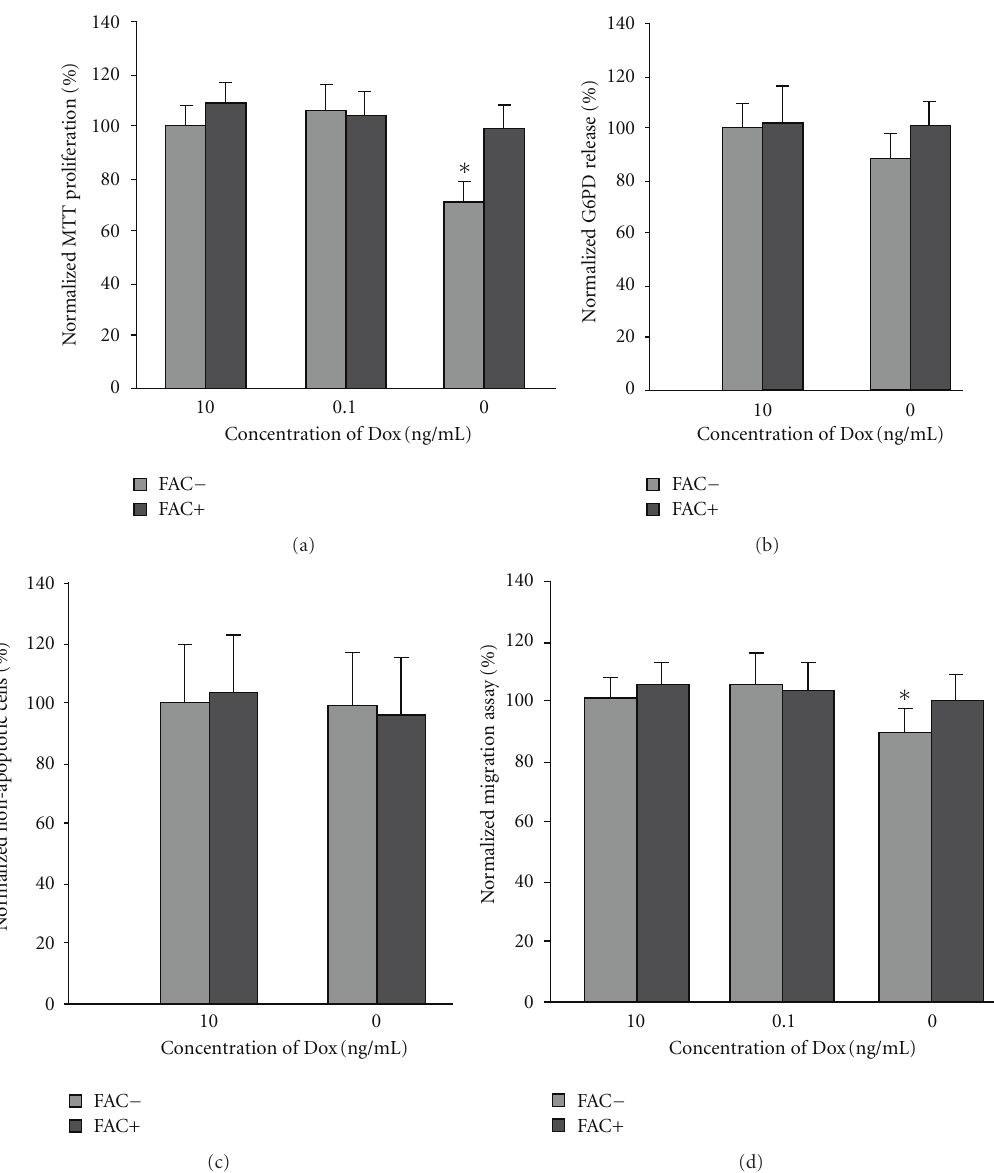
Figure 3: E ff ects of FTH1 overexpression on cell proliferation, cytotoxicity, apoptosis, and migration. (a) High expression of FTH1 reduced cell growth without iron supplementation while did not reduce cell growth with iron supplementation. MTT assay was used to assess the e ff ect of FTH1 overexpression on the cell proliferation. (b) FTH1 overexpression did not increase the release of G6PD regardless of Fe supplementation. High G6PD release represents increased toxicity. (c) FTH1 overexpression did not increase the cell apoptosis by hoechst apoptosis assay regardless of iron supplementation. (d) High expression of FTH1 reduced cell migration without iron supplementation while did not reduce cell migration with iron supplementation. Data were normalized by those in B-7 cells in 10ng/mL Dox which was defined as 100%; G6PD, glucose-6-phosphate dehydrogenase. Data were expressed as mean ± SD from 6 experiments. ( ∗ P < 0 . 05: two-tailed unpaired t